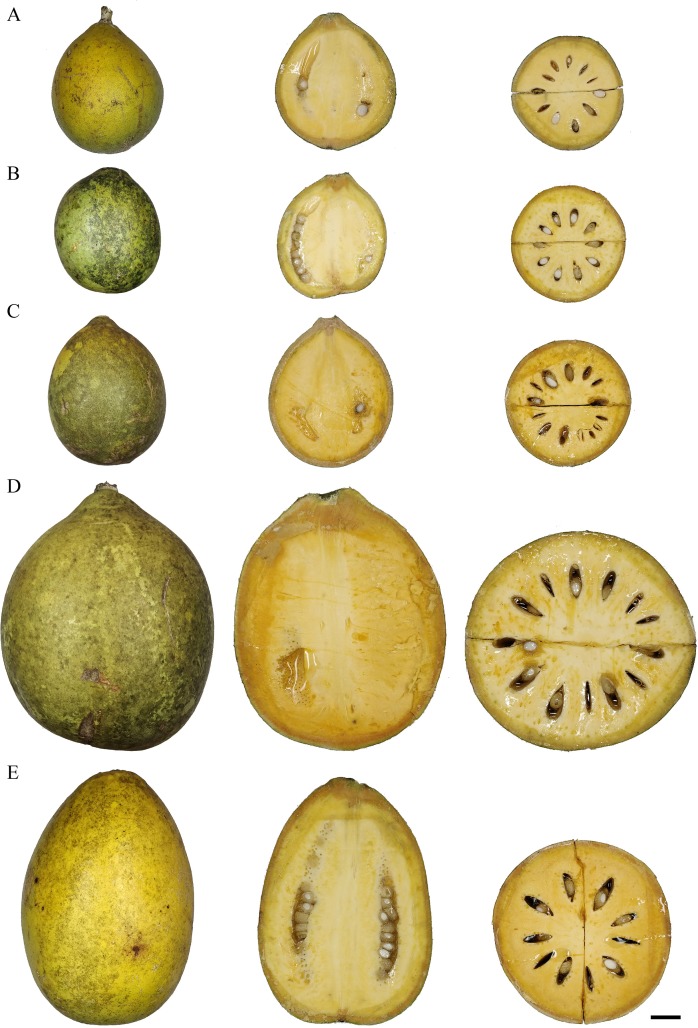
The appearance of the representative fruits of the elite bael accessions.A: BB; B: PA; C:MA; D: RA; E: PS. The side-view, longitudinal and cross sections are shown from the same fruit for each accession. Scale bar: 1 cm.